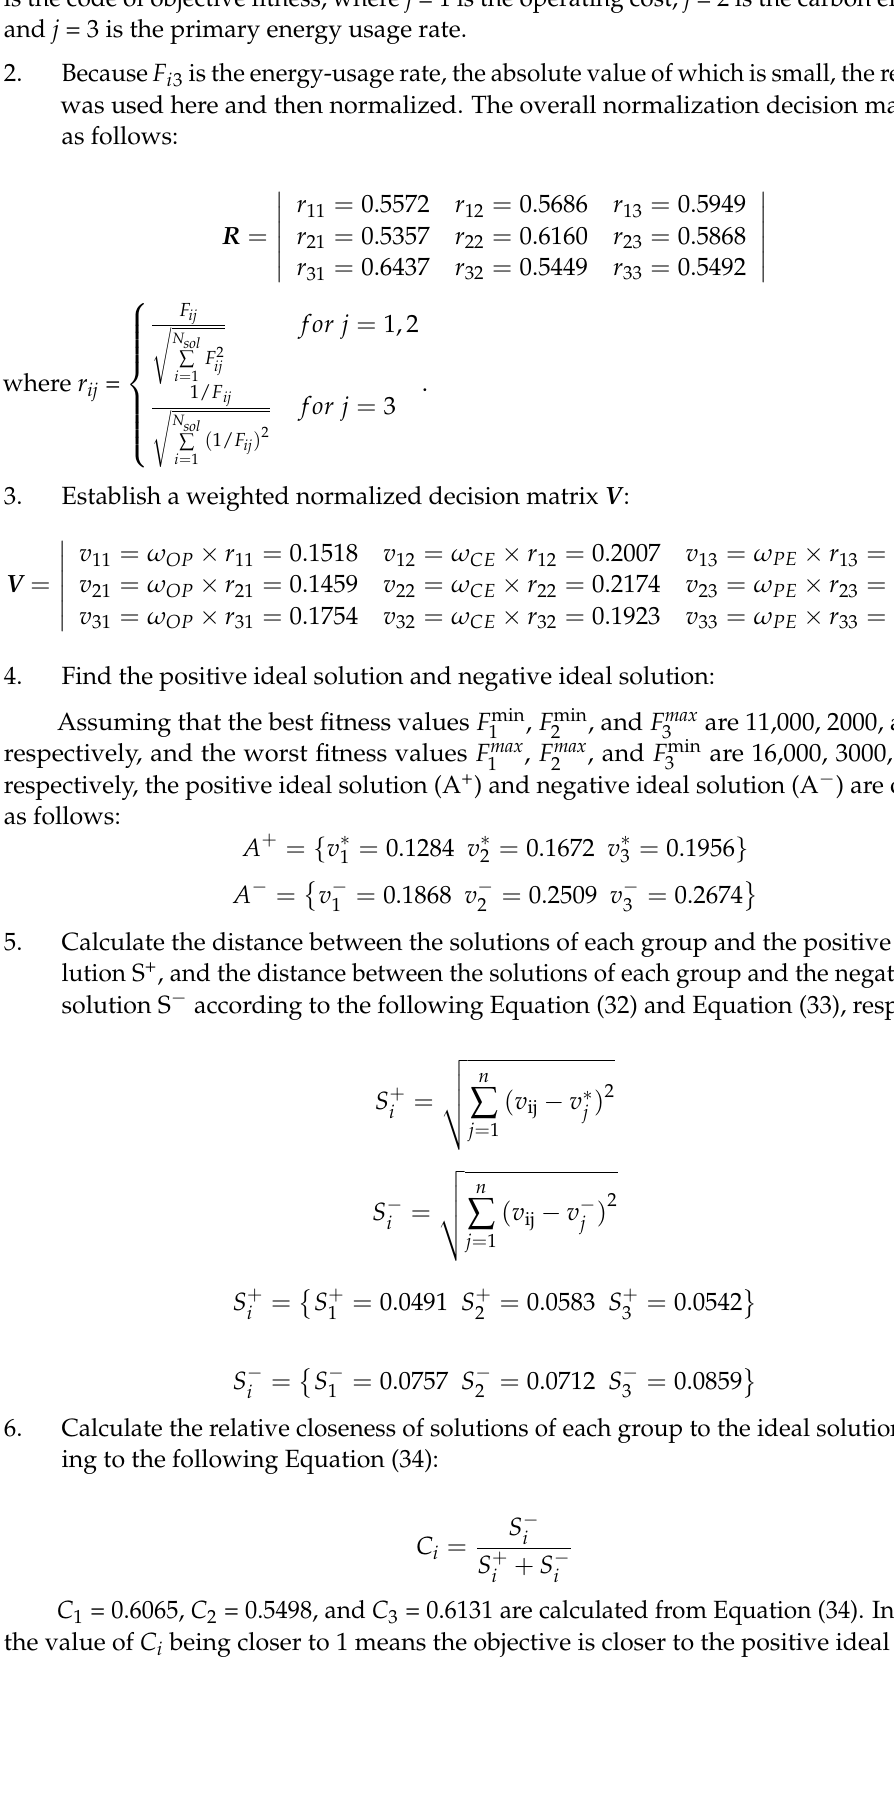
the value of C i being closer to 1 means the objective is closer to the positive ideal